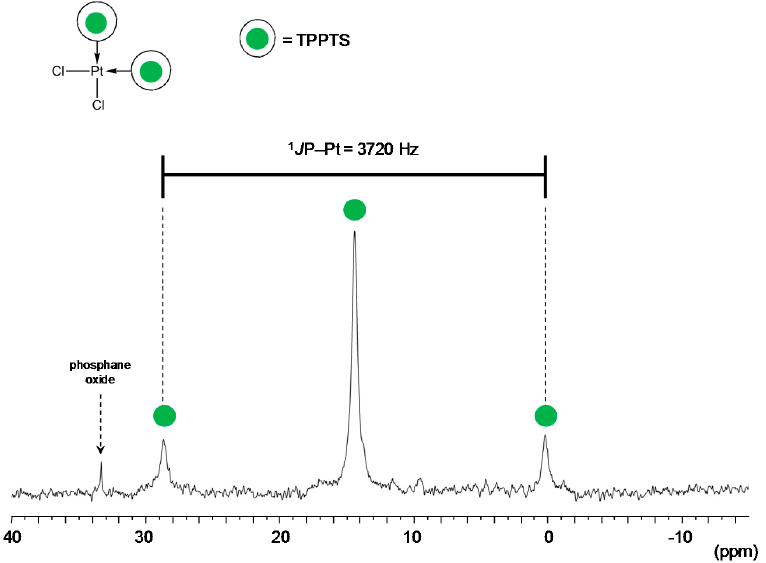
◦ C in D 2 (TPPTS) 2 , [Pt] = 10 mM, 25 2